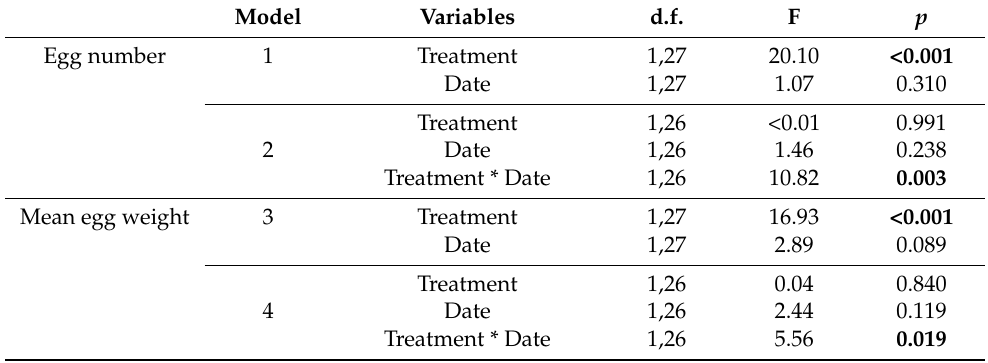
Table 1. General Linear Models exploring the effects of treatment and date in egg productivity (Number of eggs) and size (mean egg size) of laying hens. Treated hens received a basal diet supplemented with a commercial Alliaceae extract. Significant values were set at 0.05, which are in bold. Degrees of freedom (d.f.) are also shown. * means interaction